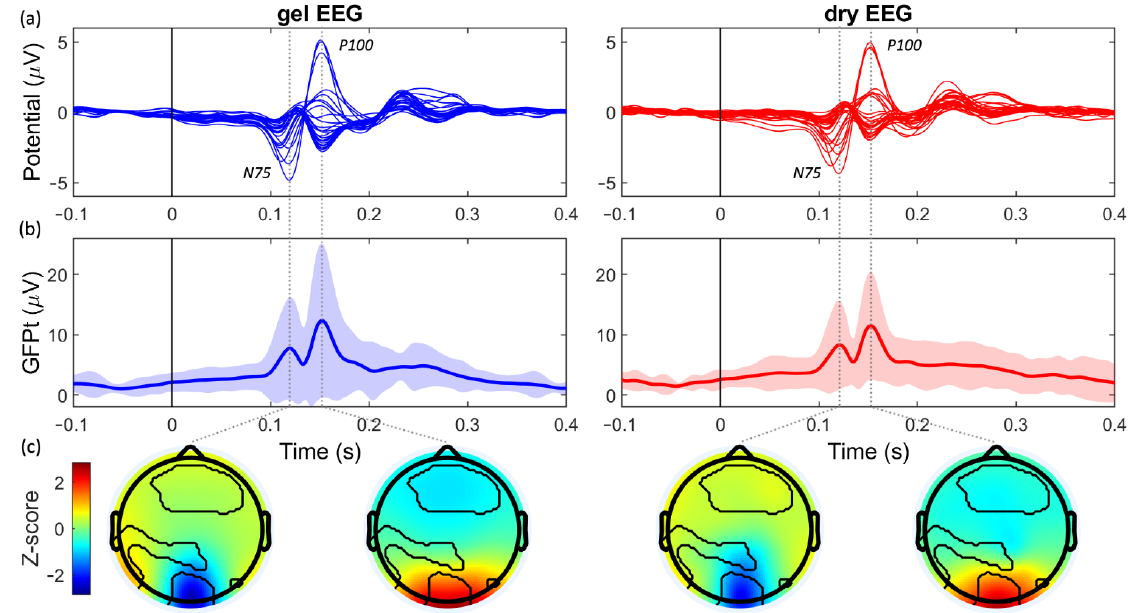
Figure 2. Pattern-reversal visual evoked potential (VEP) evoked by the checkerboard paradigm, for the gel EEG system (blue; left) and dry EEG system (red; right). ( a ) The average VEP ( μ V) per channel over subjects. ( b ) The global field power over time (GFPt; μ V) averaged over subjects. Shaded areas indicate the confidence interval (mean ± 2x standard deviation). ( c ) The standardized topographic distribution (Z-score) of the two main components of the VEP. Black lines encircle the pixels that were significantly different between the two systems.